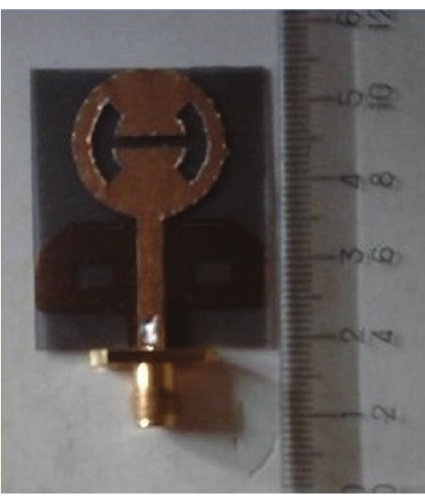
Figure 19: Photograph of the proposed antenna.